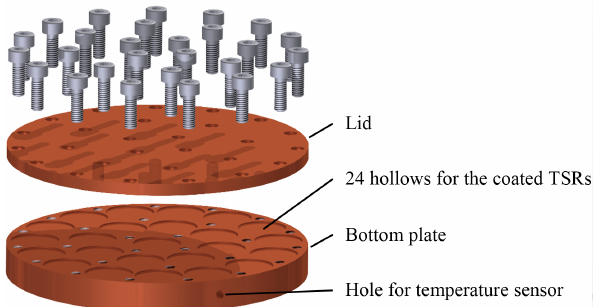
Figure 8. Cross-linking